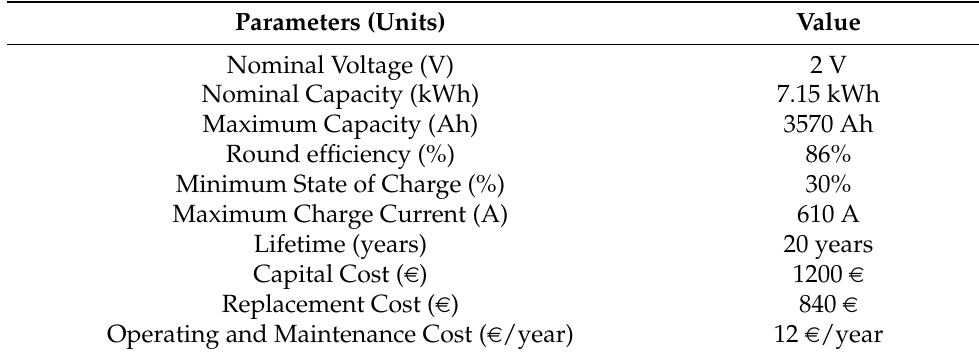
Table 7. Technical specifications and costs of Hoppecke 24 OPzS 3000